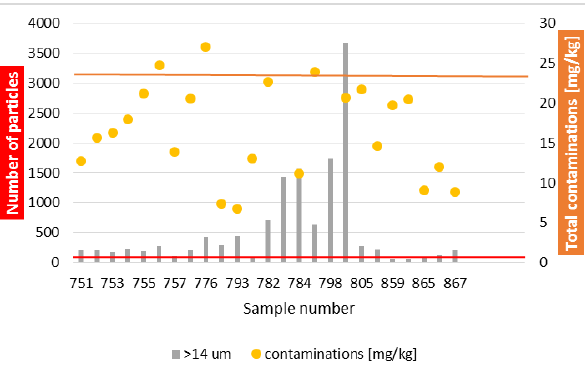
Fig. 10. Weight and quantity content of particulate matter (for particle size > 14 µm) in studied samples of diesel